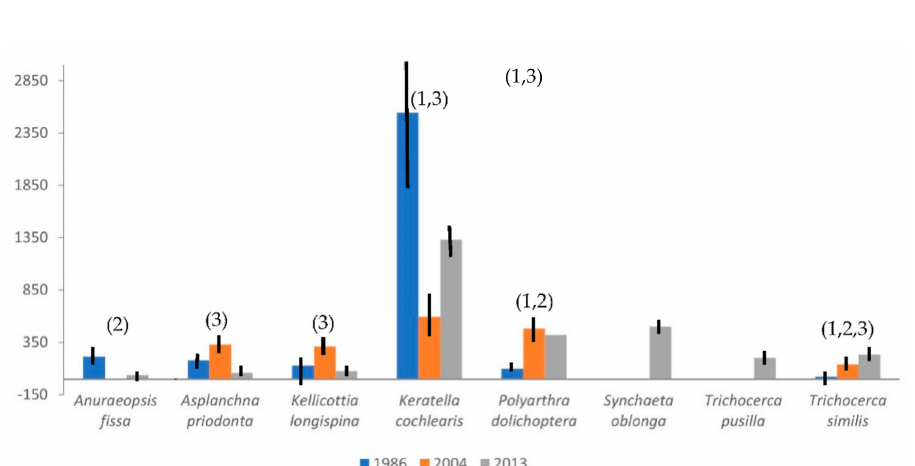
Figure 5. Variability (mean, standard deviation) of the abundance [indiv. L − 1 ] of dominant planktonic rotifer species in Lake Kortowskie. The significance of differences ( p < 0.05) between years were indicated as follows: (1)–the difference between 1986/2004; (2)–the difference between 1986/2013; (3)–the difference between